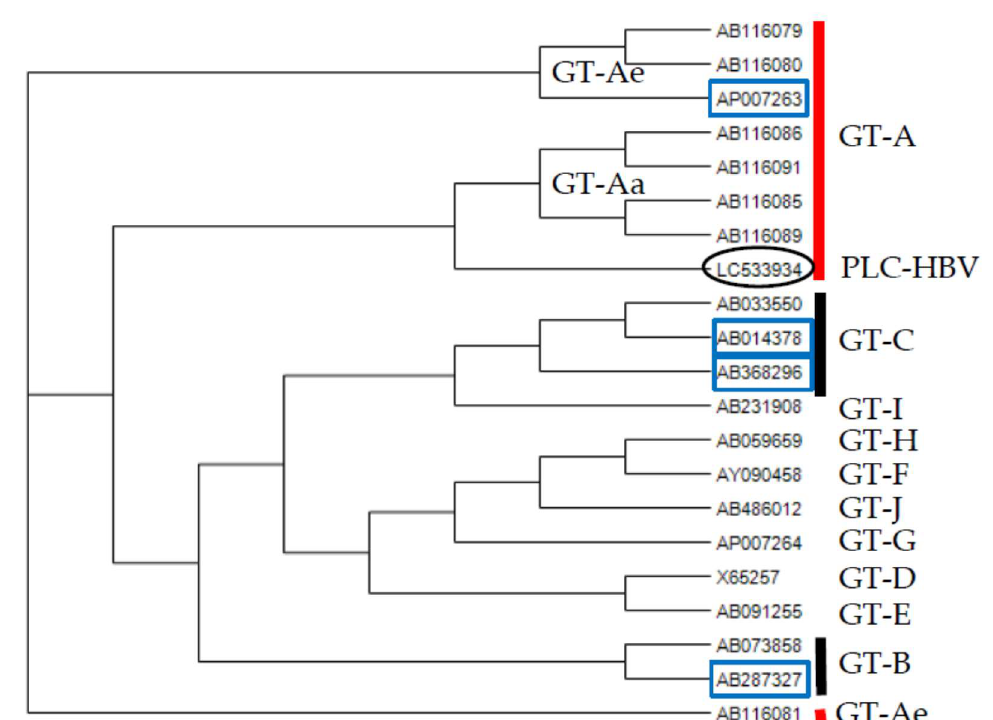
Figure 1. Phylogenetic tree for the hepatitis B virus (HBV) full-length genome obtained in the present study as determined by neighbor-joining (NJ) methods. Black circle , PLC-HBV (LC533934); blue square , reference sequences in the present study. GT-Ae, the original European genotype A; GT-Aa, the new African / Asian genotype A. The accession numbers of sequences of various HBV genotypes (GTs) are indicated [21–23,27,28]. Table 2. HBV and human genomes in PLC / PRF / 5 cells determined by HBV sequence capture-based next-generation sequencing. Human Chromosome